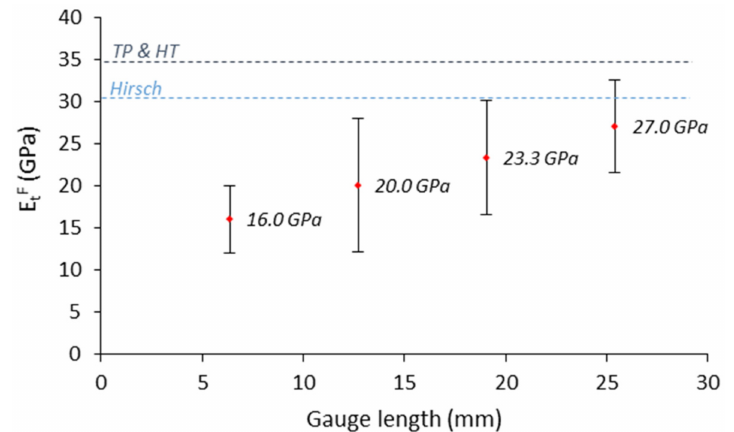
Figure 6. Intrinsic Young’s modulus of henequen fibers at different gauge